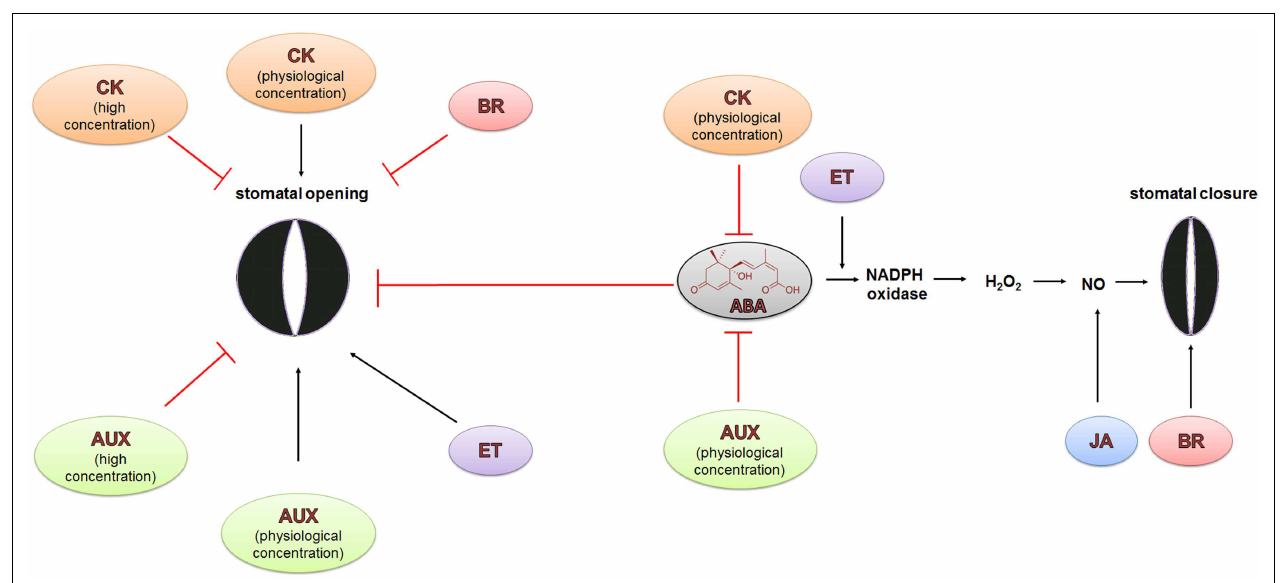
whereas the role of other hormones is ambiguous. Cytokinins (CK) and auxins (AUX) in low physiological concentrations promote stomatal opening while in high concentrations, they are able to inhibit this process.The role of ethylene (ET) is the most curious. It can stimulate the closing and opening of the stomata.The details are described in the